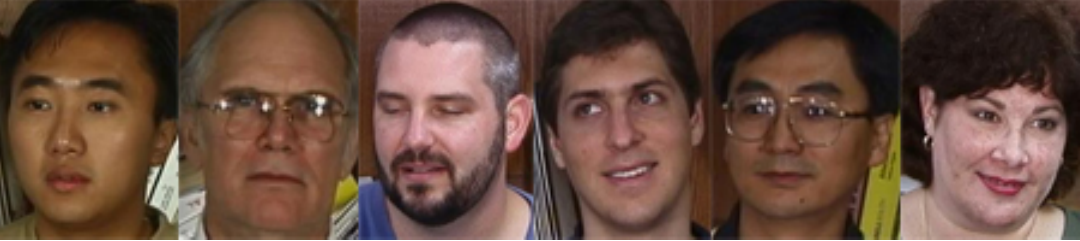
Figure 15. Sample images from the Georgia Tech face